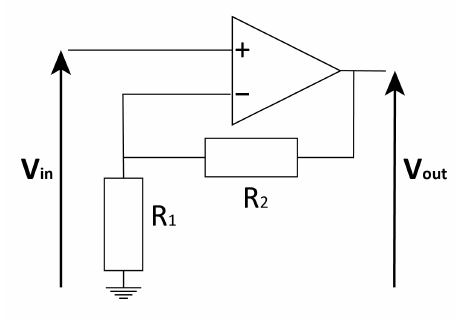
Figure 3: Voltage